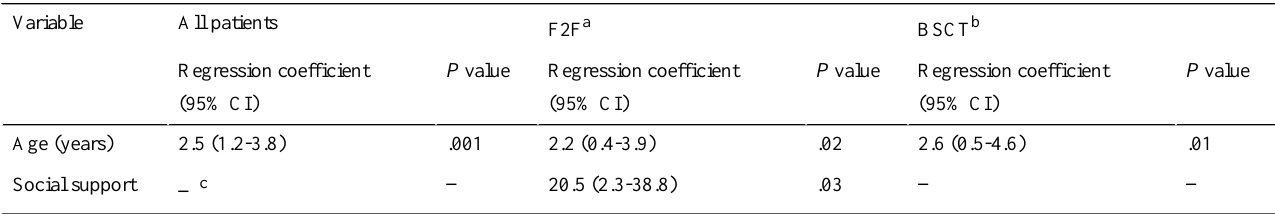
Table 5. Multivariate model of patient characteristics predicting adherence for all patients and each treatment